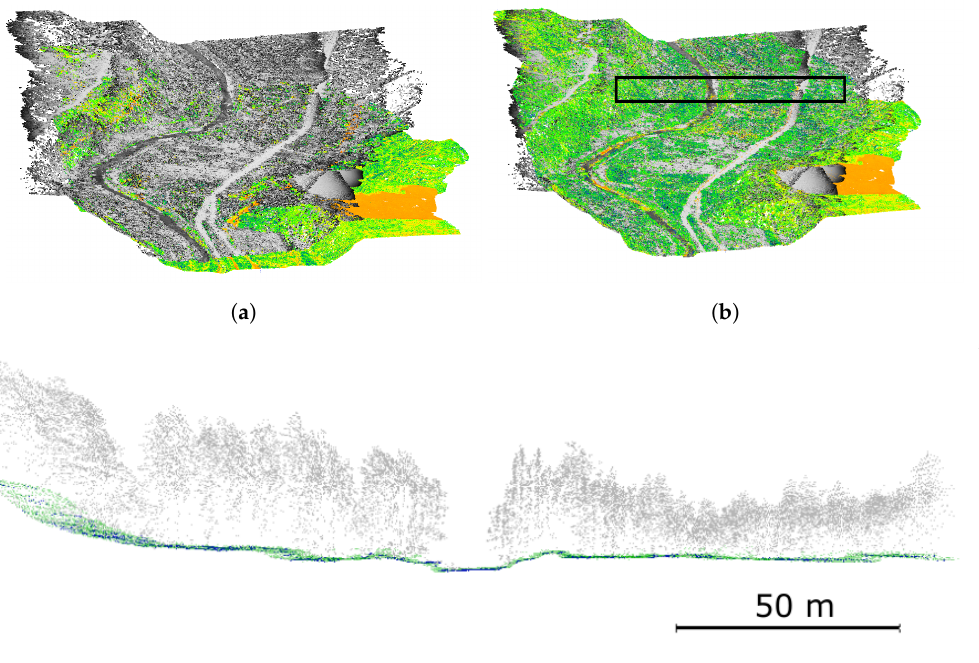
Figure 6. Result of the proposed approach shown on the third scene. ( a ) Overview of the third scene with initial transformation. ( b ) Overview of the third scene with registration result. ( c ) Profile view of the marked area in ( b ). Shown data are the original data of 2012 and the data of 2017 downsampled to 0.5 m GSD. The color representation is the same as in Figure 3.